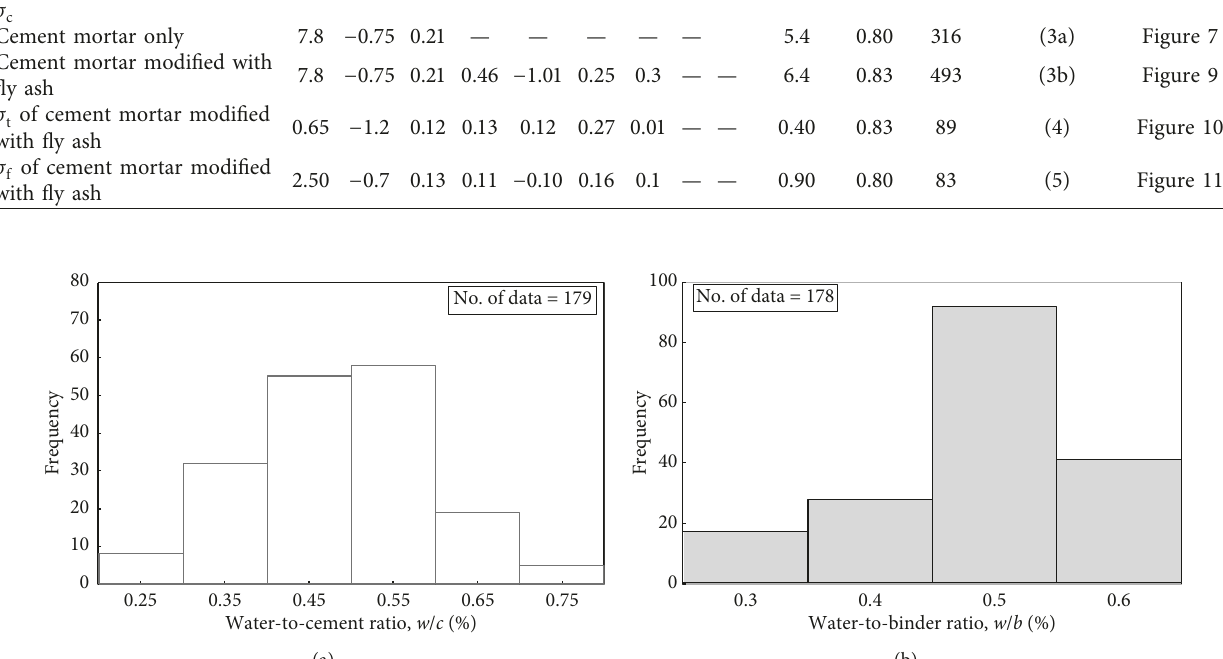
Table 3: Model parameters for compressive, tensile, and flexural strength relationships of cement mortar with and without fly ash (FA). Dependent variable ( y -axis) Split tensile strength, σ t (MPa), for cement mortar only (MPa), for cement mortar modified with fly ash Flexural strength, σ f (MPa), for cement mortar only for cement mortar modified with fly ash Table 4: Nonlinear model (NLM) parameters for the mechanical properties of cement mortar with and without fly ash. Model parameters σ c Cement mortar only Cement mortar modified with fly ash σ of cement mortar modified t with fly ash σ of cement mortar modified f with fly ash